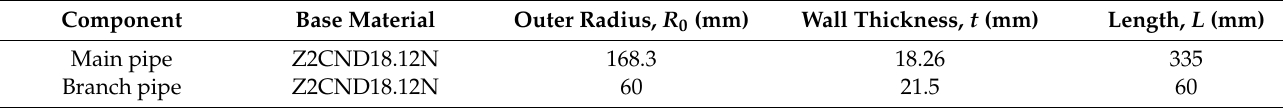
Table 1. Summary of the test component dimensions.